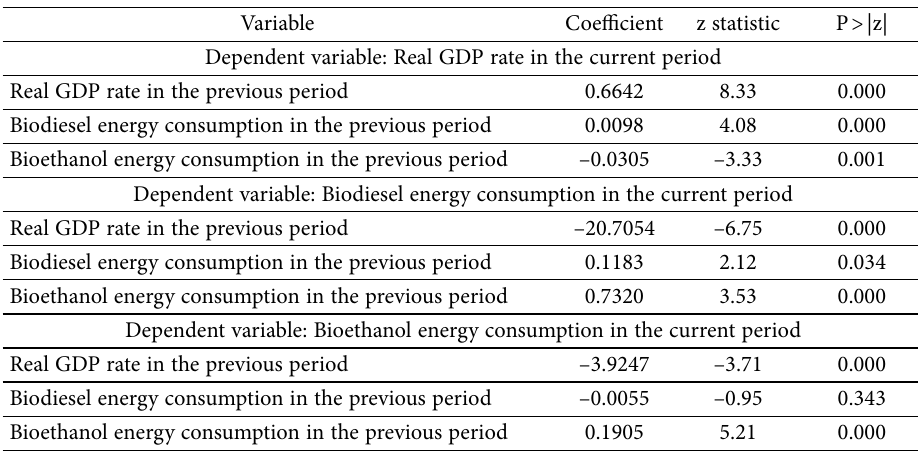
Table 3. Panel VAR model estimation for explaining economic growth, biodiesel and bioethanol energy consumption in transport in the EU-28 countries during 2010–2015